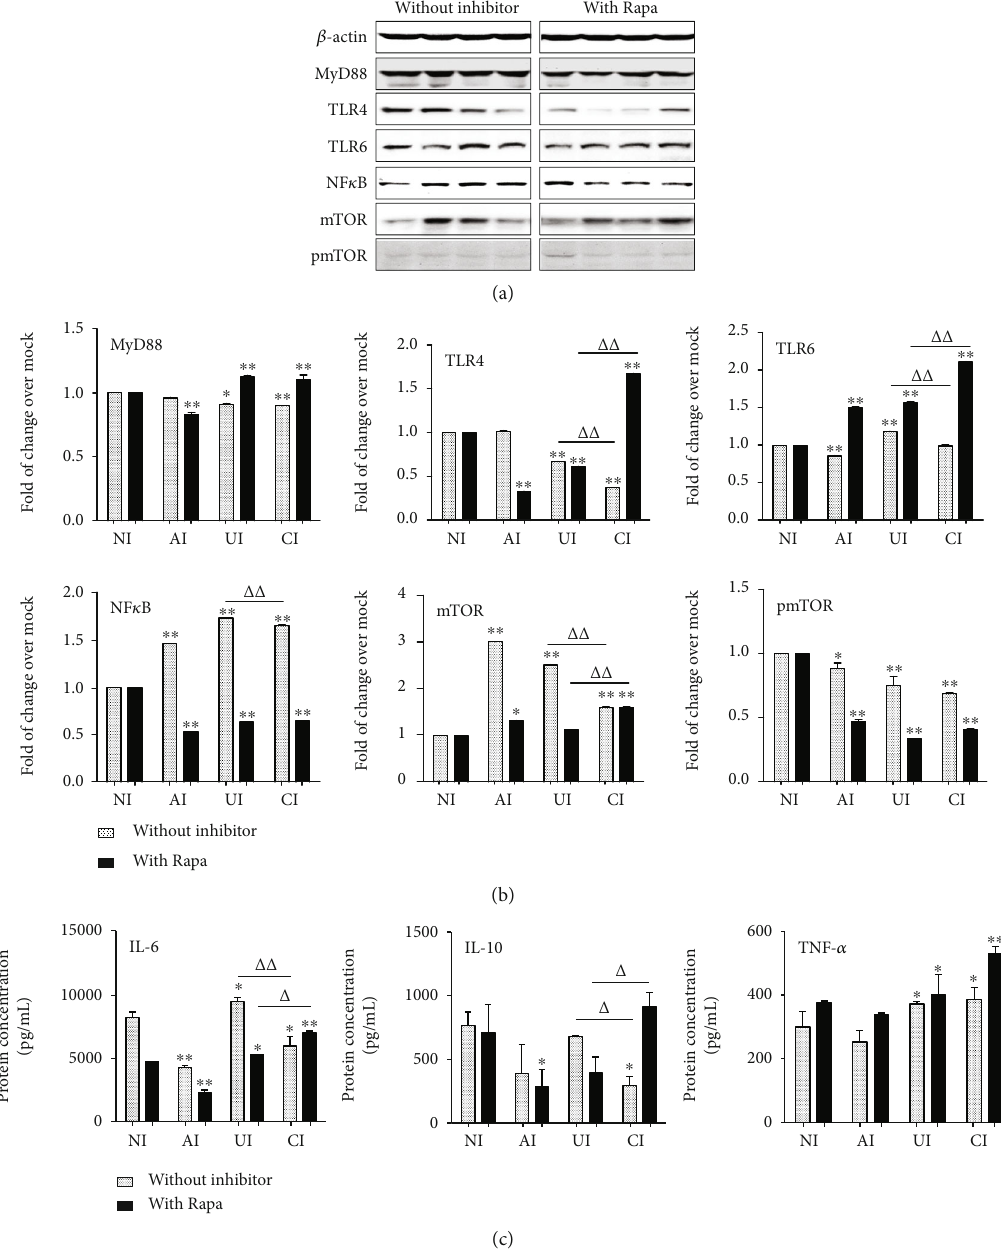
Figure 9: Impact of mTOR on the expression of TLR ligands and elements of the TLR signaling pathway in U937 cells to H37Rv infection in the A549 cell coculture model. In the presence or absence of mTOR inhibitor rapamycin, the coculture model of A549/U937 cells was infected with H37Rv mycobacteria from the upper chamber (A549 cells, AI), lower chamber (U937 cells, UI), or both chambers (A549 and U937 cells, CI) at a MOI of 3 for 18h before the culture medium, and U937 cells were harvested for analysis. (a) Representative blots of immunoblotting assay for indicated components of TLR signaling cascade showed an increased expression of TLRs and MyD88 but a reduced expression of NF κ B in U937 cells of the coinfection model in the presence of rapamycin, in comparison with the absence of an inhibitor. (b) The fold of changes of proteins of interest is (a) semiquantitatively determined by densitometric assay using ImageJ software from three independent experiments. (c) Concentrations of TNF- α , IL-10, and IL-6 in culture media determined by ELISA. An increased TNF- α was observed in the presence of mTOR inhibitor rapamycin. The A549 cell-mediated reduction of cytokines in the Mtb H37Rv-infected U937 cells was reversed in the presence of mTOR inhibitor rapamycin. Error bars represent the standard deviation (SD) from three independent experiments. Compared to noninfection (NI) control, ∗ p < 0 05 and ∗∗ p < 001 ; compared to the absence of LiCl, Δ p < 0 : 05 and ΔΔ p < 0 : 01 . NI: noninfected control; AI: infection was performed on A549 cell alone; UI: infection was performed on U937 alone; CI: infection was performed on both A549 cells and U937